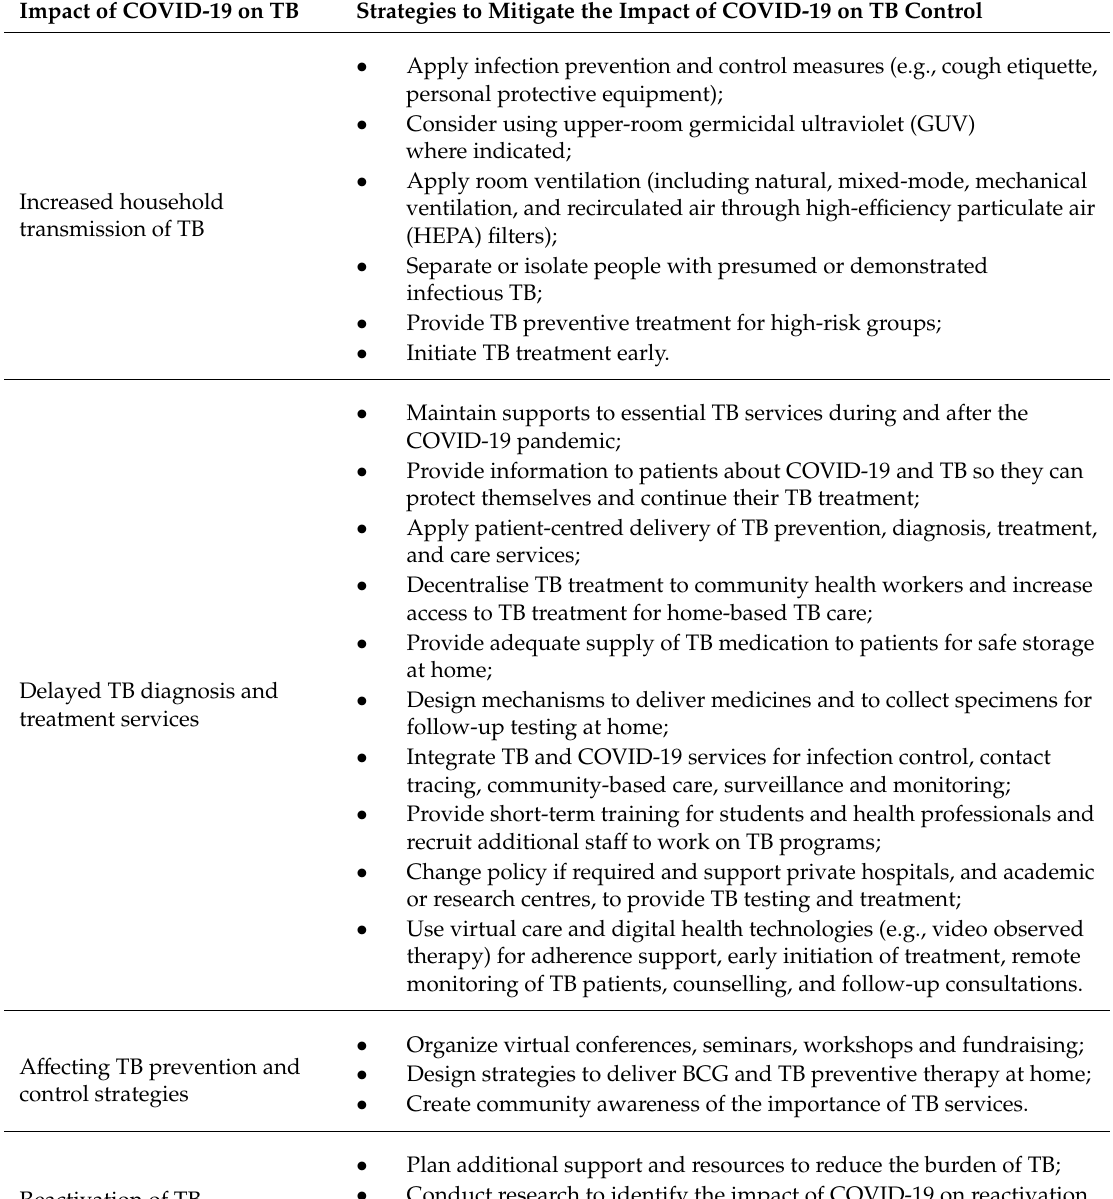
Table 1. Possible strategies to mitigate the impact of COVID-19 on tuberculosis (TB)